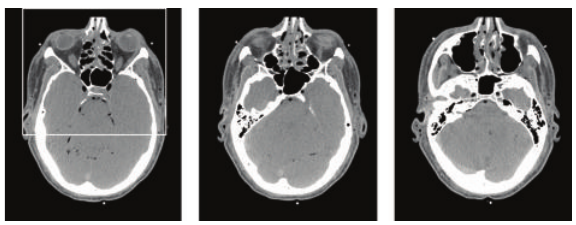
Figure 10: Few example images of head sections. The marked region in the test image (on the left) is zoomed on in Figure 11.